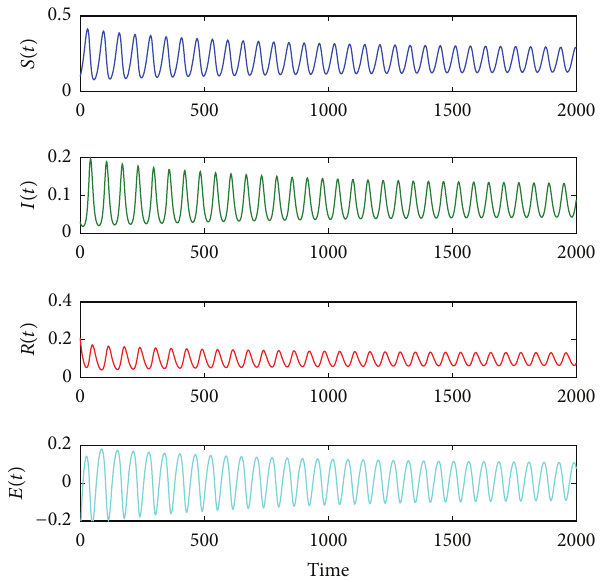
Figure 5: Dynamical responses of model system (4) with time delay 𝜏 = 3 , which shows that model system (4) is unstable around (0.2, 0.08, 0.0907, 0.0147) .